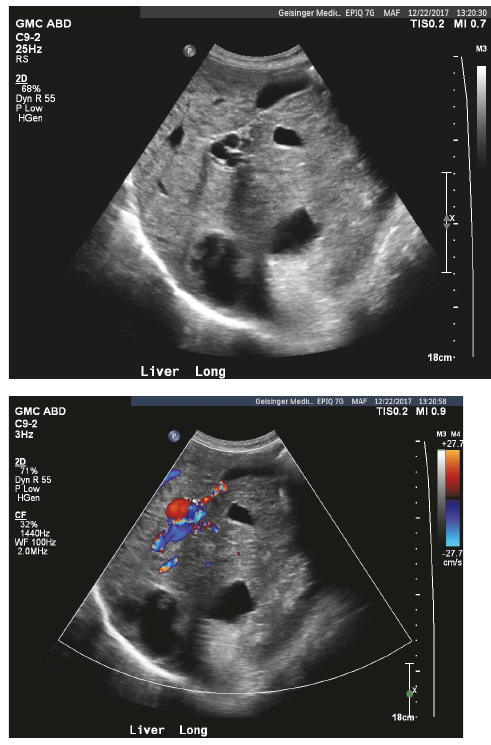
Figure 1: (a) Ultrasound gray scale image shows multiple anechoic structures in the liver with surrounding echogenicity. There is flow on color Doppler (b), consistent with hepatic arteriovenous malformations.